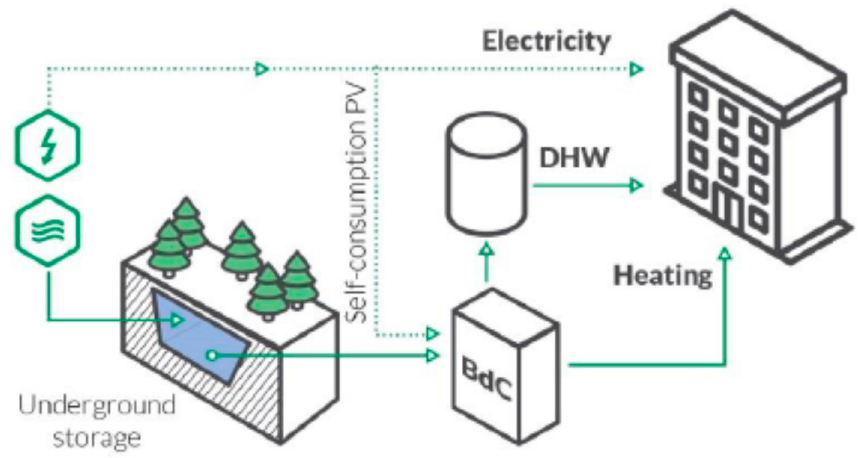
Figure 1. Principle of operation of the proposed installation (source: Abora Solar SL [14]).